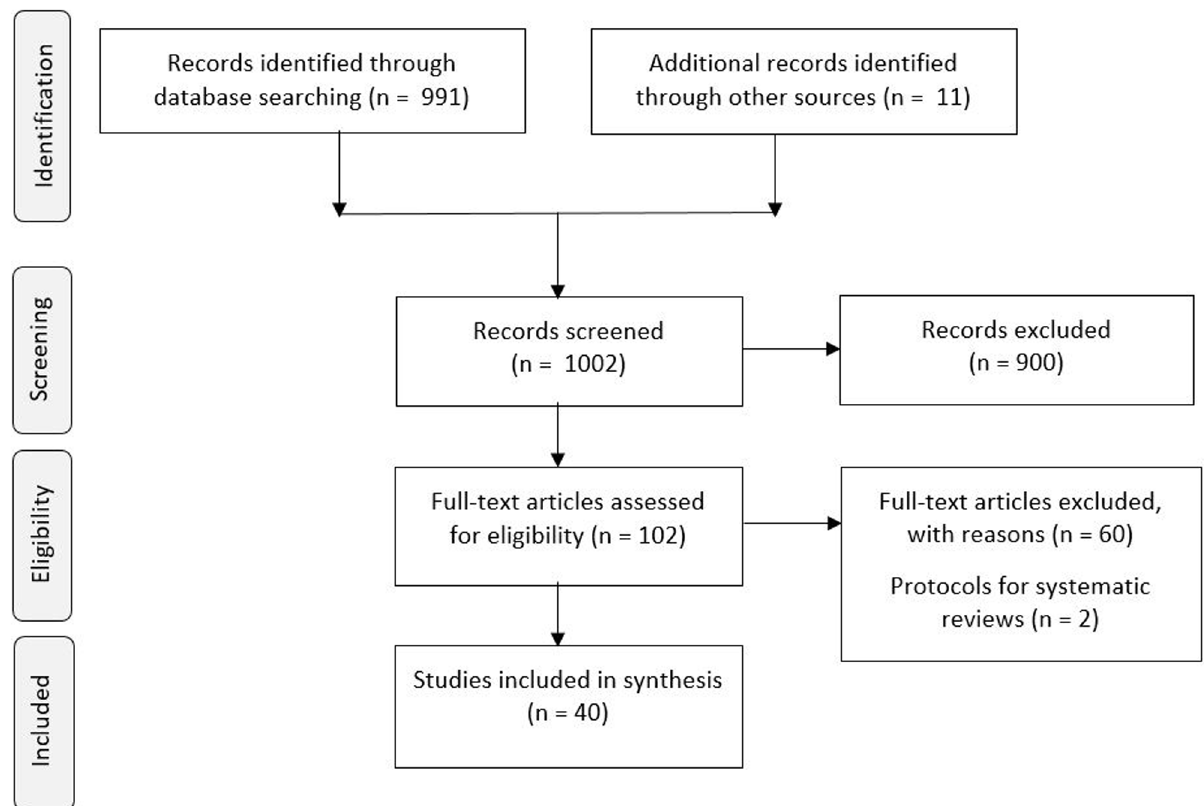
Fig 1. Literature search and selection